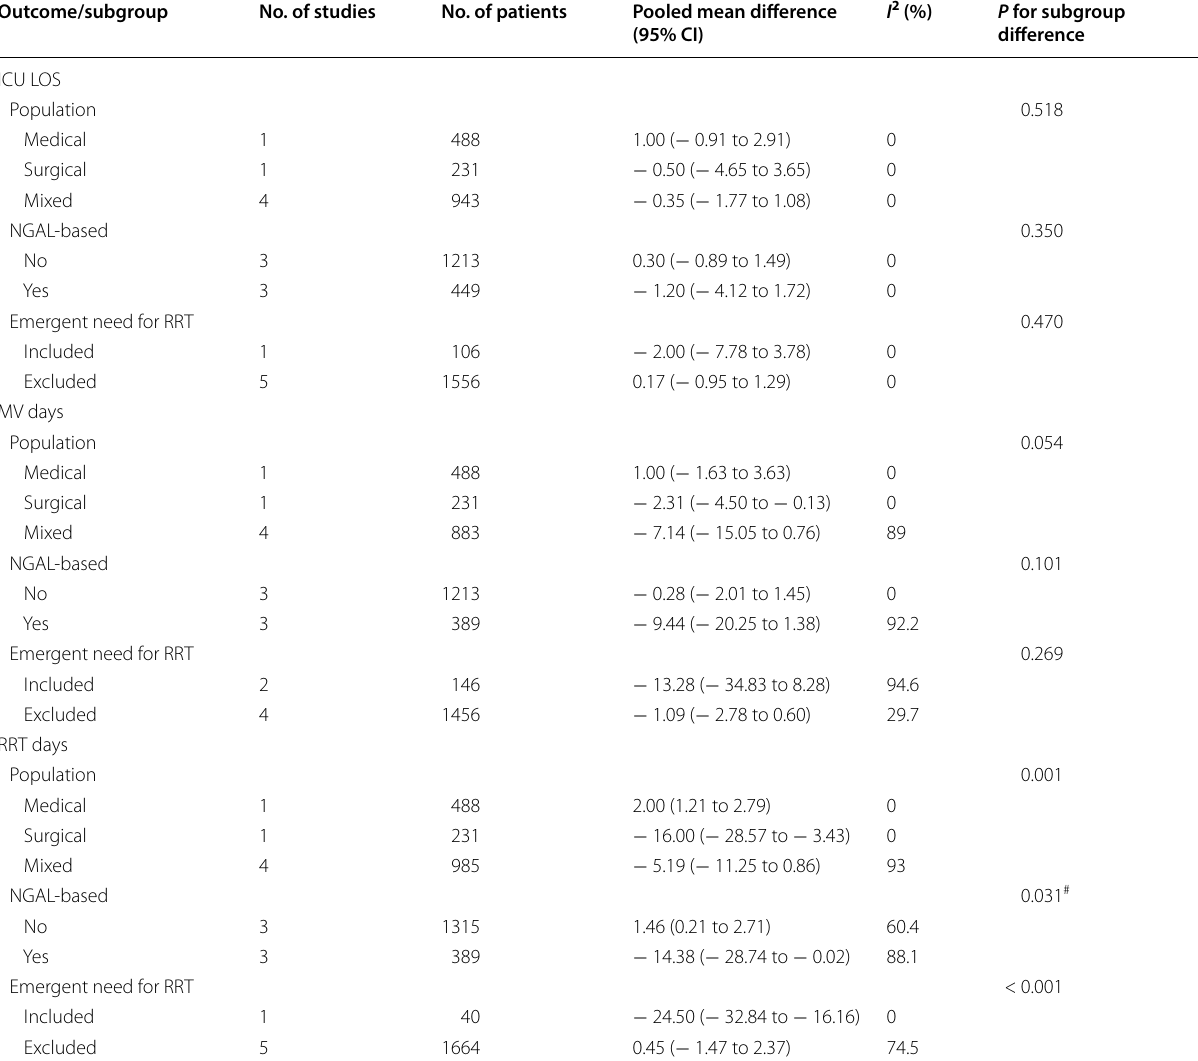
Table 2 Subgroup analysis of ICU days, MV days, and RRT days in the included randomized controlled